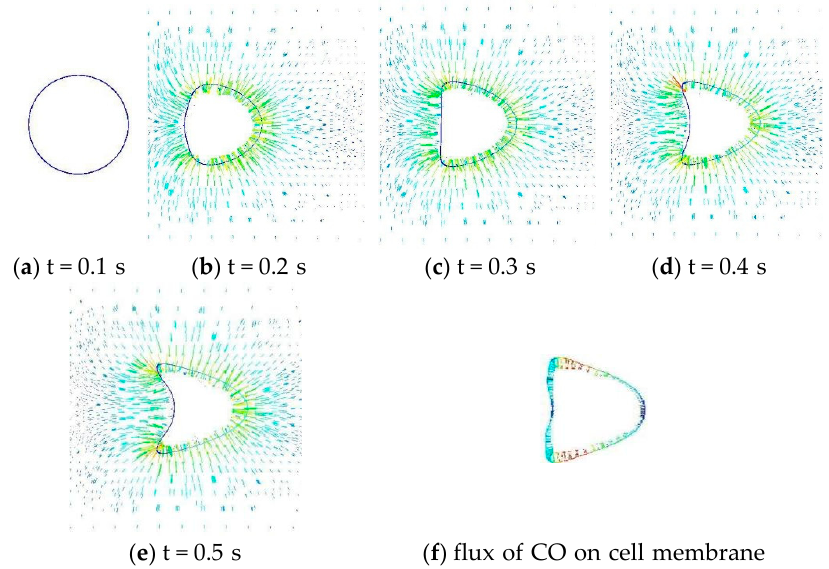
Figure 4. The deformation of an RBC under capillary flow in a cylindrical pulmonary vessel and the uptake of CO during this process.